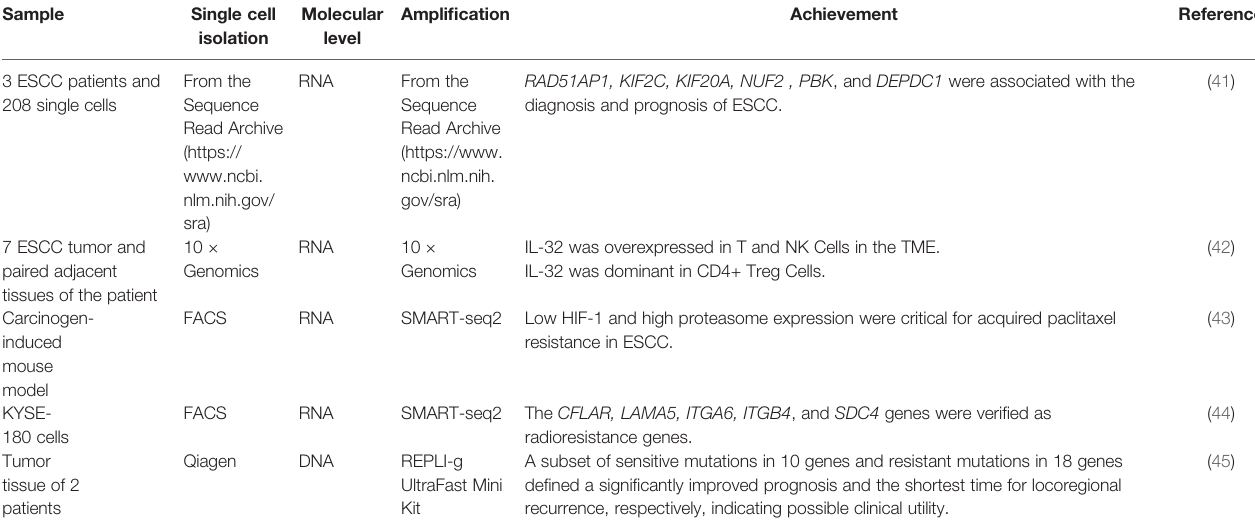
TABLE 6 | SCS in diagnosis and treatment of esophageal